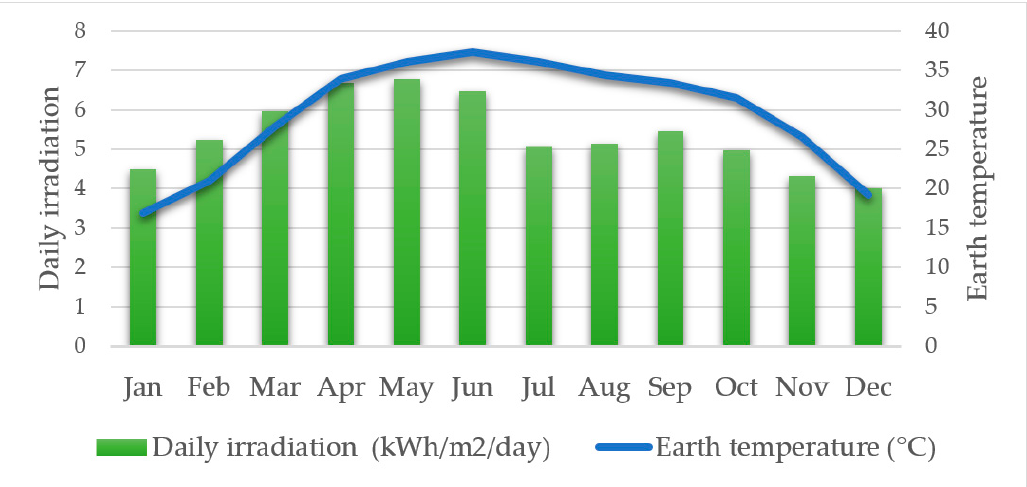
Figure 4. The Badin region daily solar irradiance received.